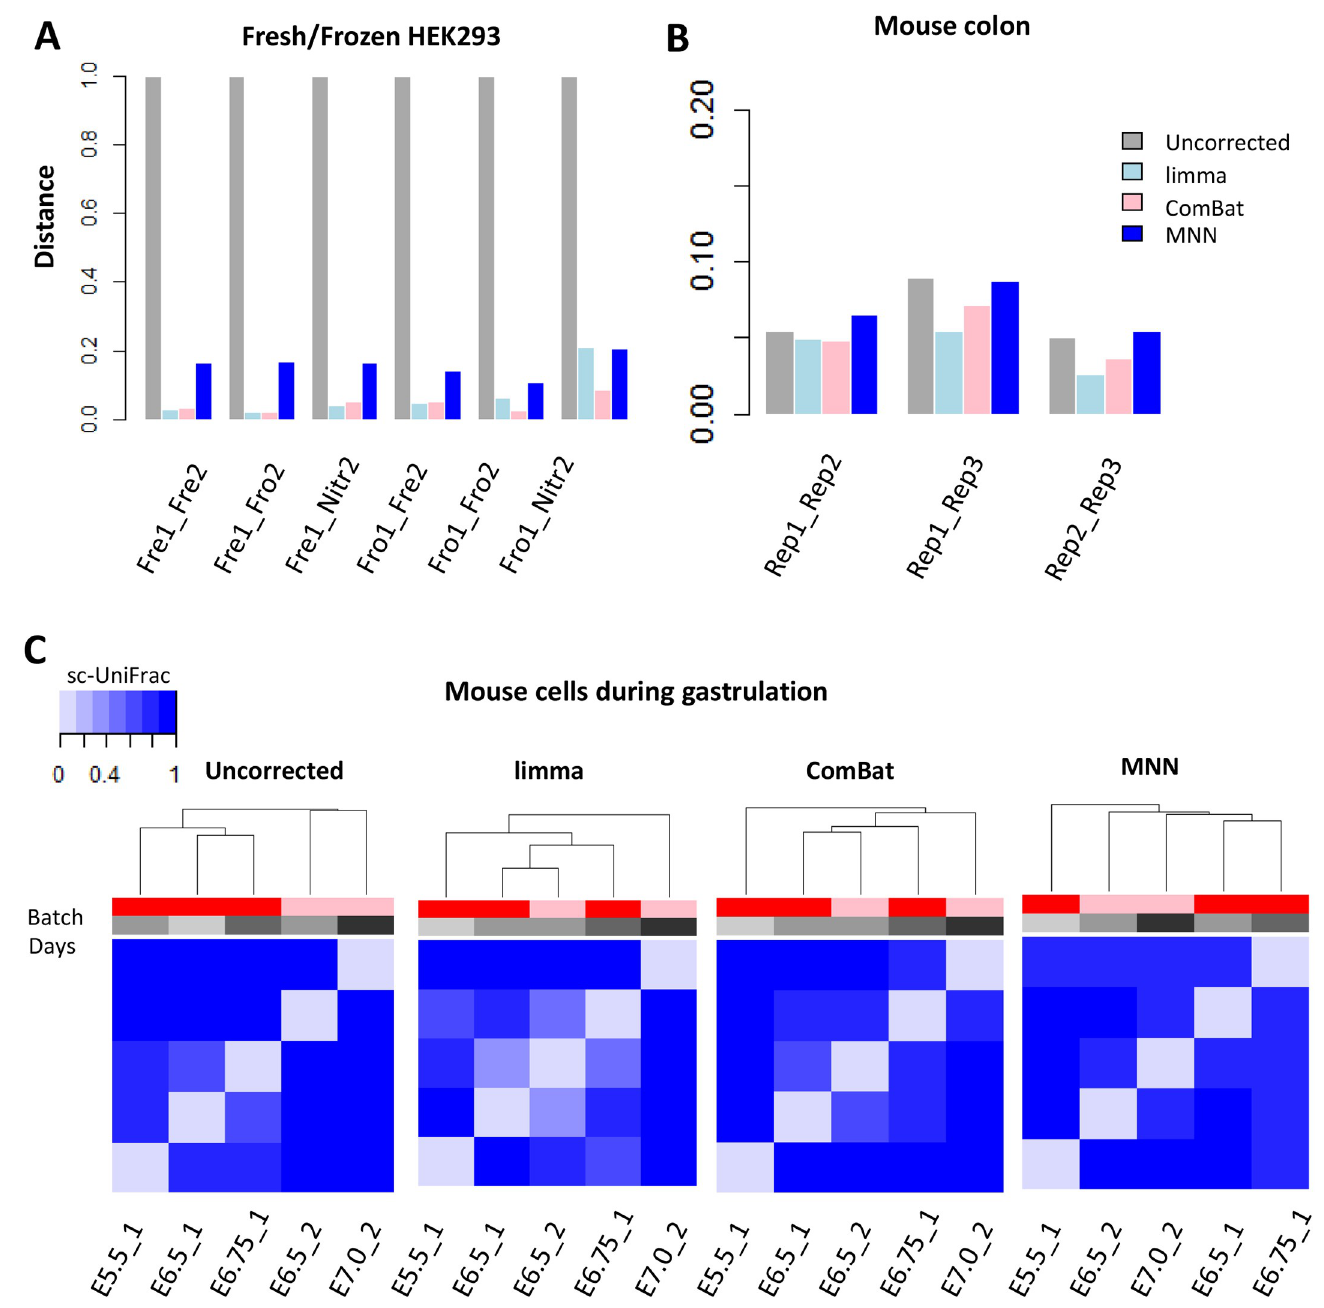
Fig 8. sc-UniFrac can benchmark batch effect removal approaches. (A) sc-UniFrac distance calculated comparing uncorrected and batch-corrected scRNA-seq datasets of HEK293 cells fresh, frozen at − 80 ˚C, or liquid nitrogen flash frozen performed in two different batches (GSE85534) [35]. ComBat, limma, and MNN were used for batch correction. (B) sc-UniFrac distance calculated similar to panel A for technical replicates of the mouse colonic epithelium scRNA-seq data (GSE102698). (C) Hierarchical clustering by sc-UniFrac of uncorrected or batch-corrected scRNA-seq data depicting murine gastrulation from two different studies [36,37].A gradation of similarity, and hence clustering, was expected over developmental times from the earliest development stage (E5.5) to the latest stage (E7.5). Data from GSE100597; http://gastrulation.stemcells.cam.ac.uk/scialdone2016. E, embryonic day; Fre, fresh; Fro, frozen at − 80 ˚C; HEK293, human embryonic kidney 293; Nitr, liquid nitrogen flash frozen; scRNA-seq, single-cell RNA sequencing.